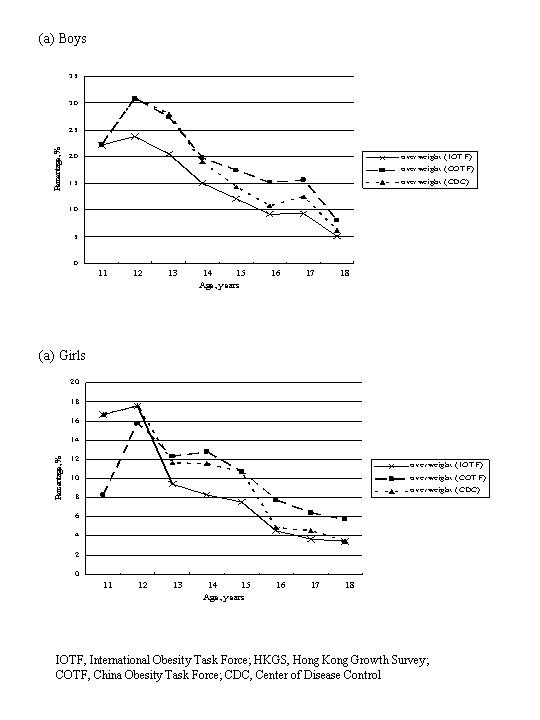
Percentages of overweight as defined by various criteria in 2098 Hong Kong Chinese adolescents categorized by age and gender.